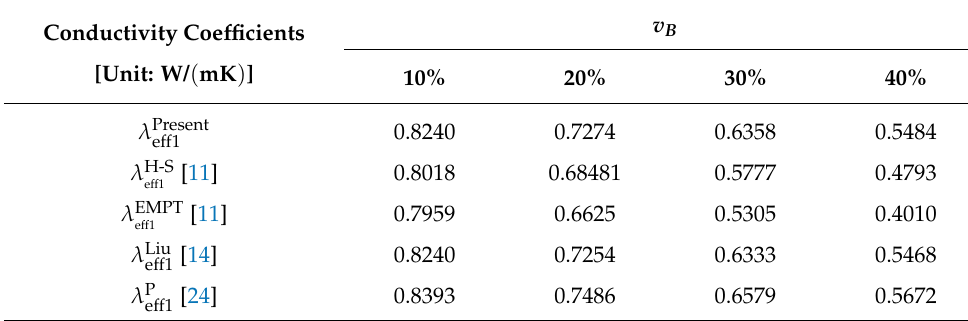
Table 2. Comparison of present conductivity coefficients of RVE 1 with results in the literature.